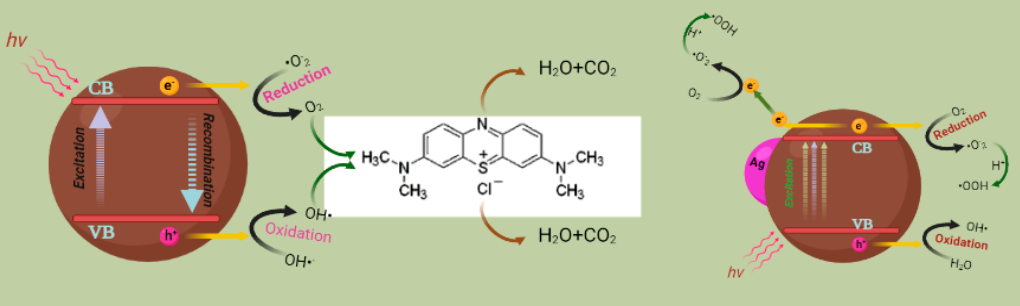
Figure 15. Schematic diagram of the proposed mechanism for the degradation of MB by ( a ) pure ZnO, and ( b ) Ag-doped ZnO nanostructures.